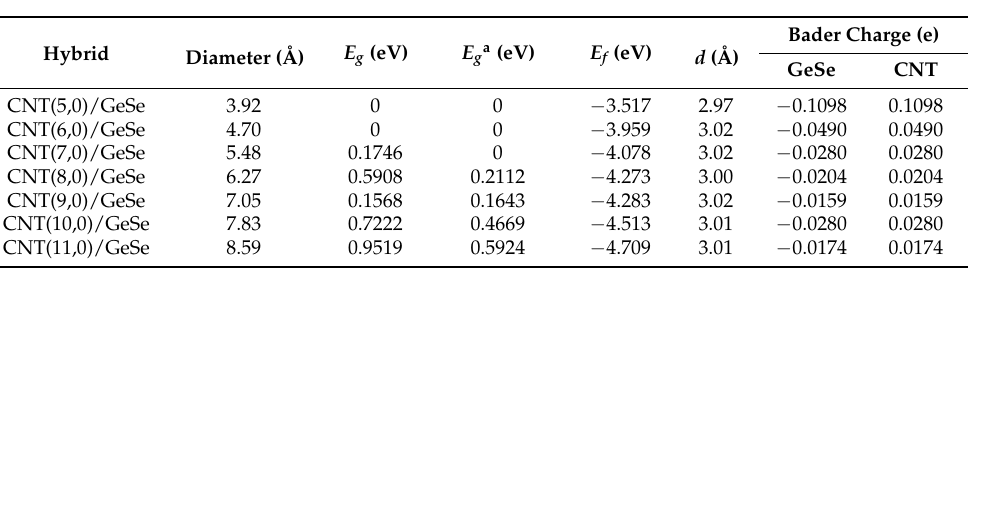
Table 1. Diameter and bandgaps of ( n ,0) CNTs ( E g ) ( n = 5–11) and formation energy, E f , bandgap, E g a , and interfacial spacing, d , of optimized CNT/GeSe hybrids. Bader charge: the positive value indicates gained electrons, while a negative value reveals lost